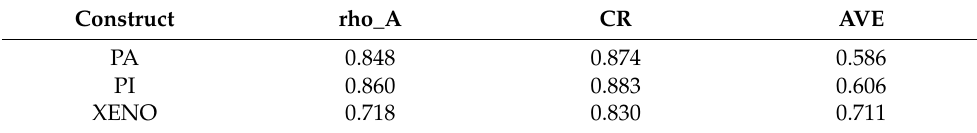
Table 5. Construct Reliability and Validity.